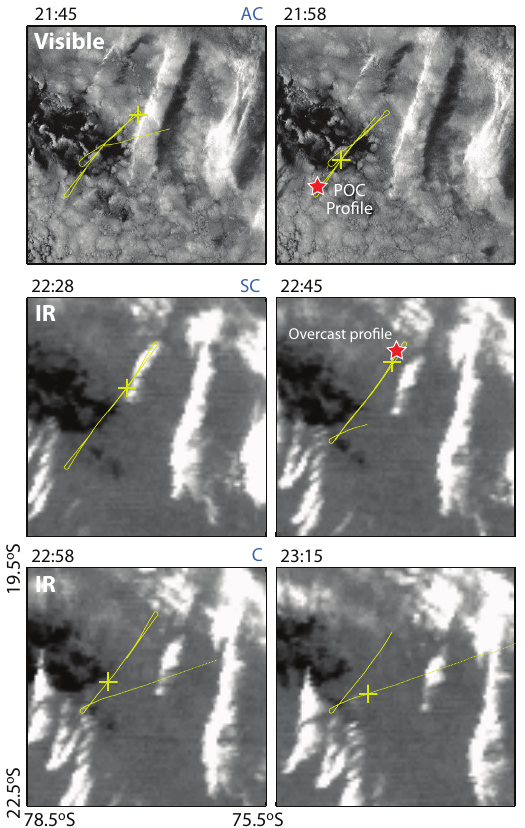
Fig. 3. GOES visible imagery (upper row) and infrared imagery (lower two rows) between 21:45 UTC and 23:15 UTC 27 October with near-coincident hour-long sections (yellow) of the BAe-146 flight track during B409, centered on the image time overlaid. The yellow cross shows the location of the aircraft at the time of the image, with the image time shown at top left of the panels. The aircraft leg closest to the image time is given in blue text at top right of panel. The red stars represent the approximate location of the aircraft during two profiles.